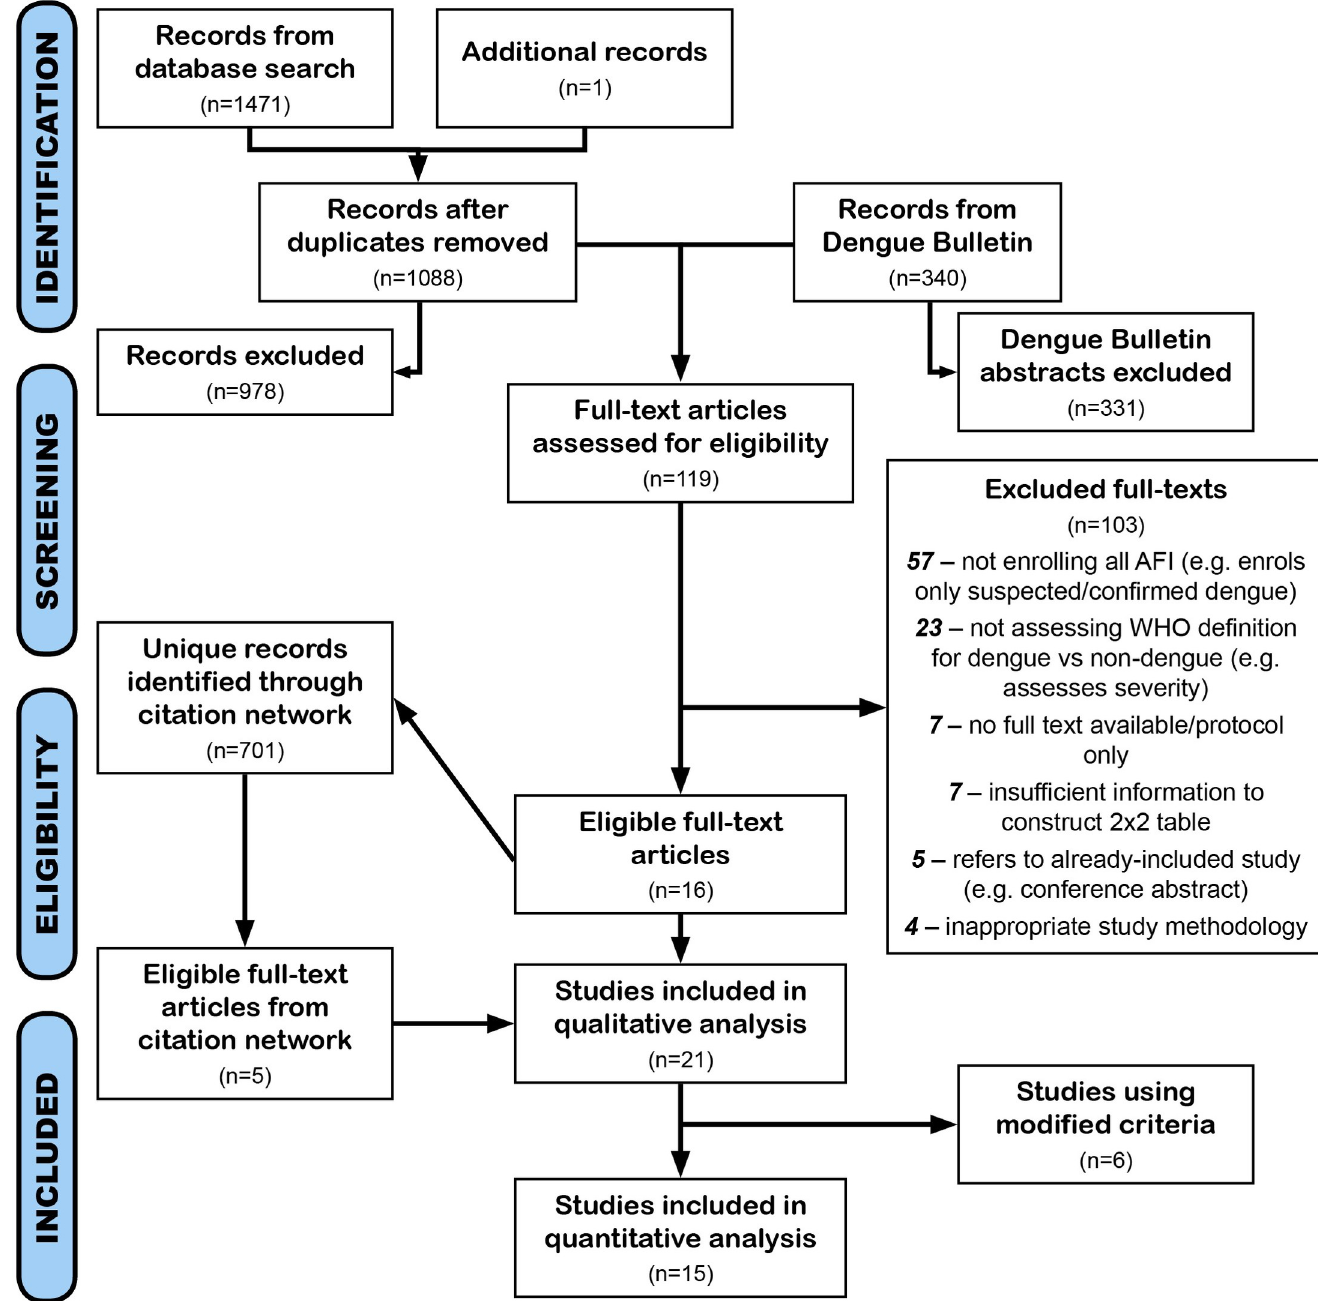
Fig 1. PRISMA flow diagram for systematic review search results. AFI: Acute febrile illness. PubMed, EMBASE, Scopus, and OpenGrey were searched for articles assessing the diagnostic accuracy of clinical criteria for dengue diagnosis, Dengue Bulletin articles and short notes were also included. The additional record was identified from previous work but did not mention WHO criteria in the title or abstract. Citation network analysis used Web of Science, Google Scholar, and reference lists. Articles assessing the diagnostic accuracy of unmodified WHO clinical criteria (1997 or 2009) for dengue were included in the meta-analysis, articles using modified criteria were included in qualitative analysis